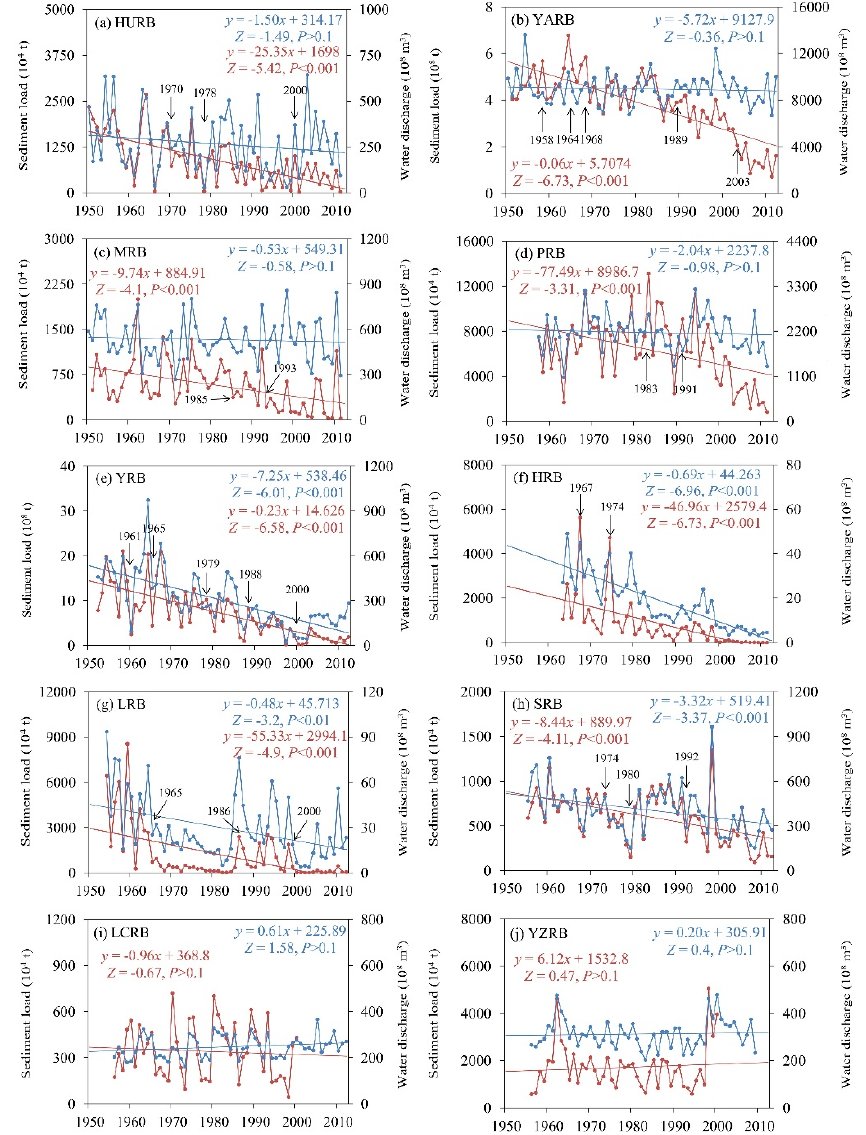
Figure 3. Interannual variability of streamflow and sediment load in major basins in China during 1950–2012. Blue and red lines represent changes in water discharge and sediment discharge,